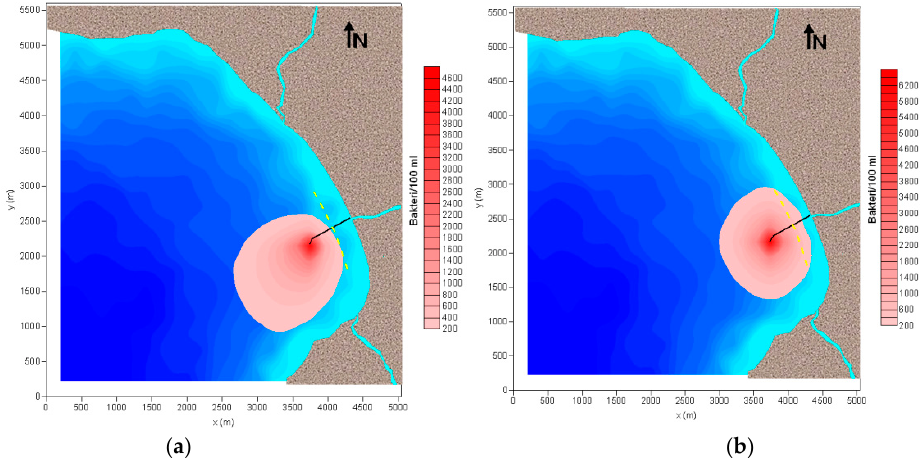
Figure 16. Distribution of the pollutant cloud caused by the wind blowing from NE at: ( a ) 10 m/s and ( b ) 2 m/s [33].